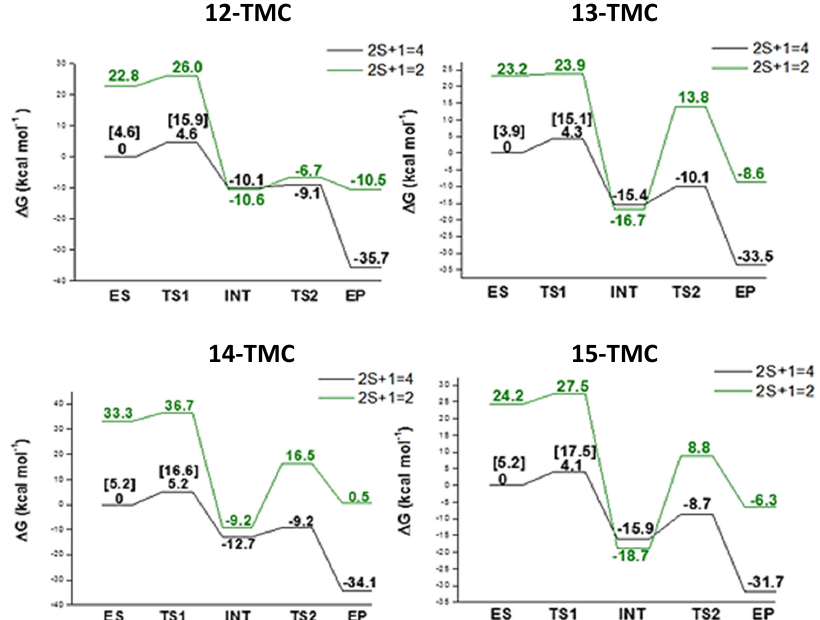
Figure 2. Potential energy surfaces for the NO oxidation reaction by end-on [Cr(III)(n-TMC)(O 2 )(Cl)] +